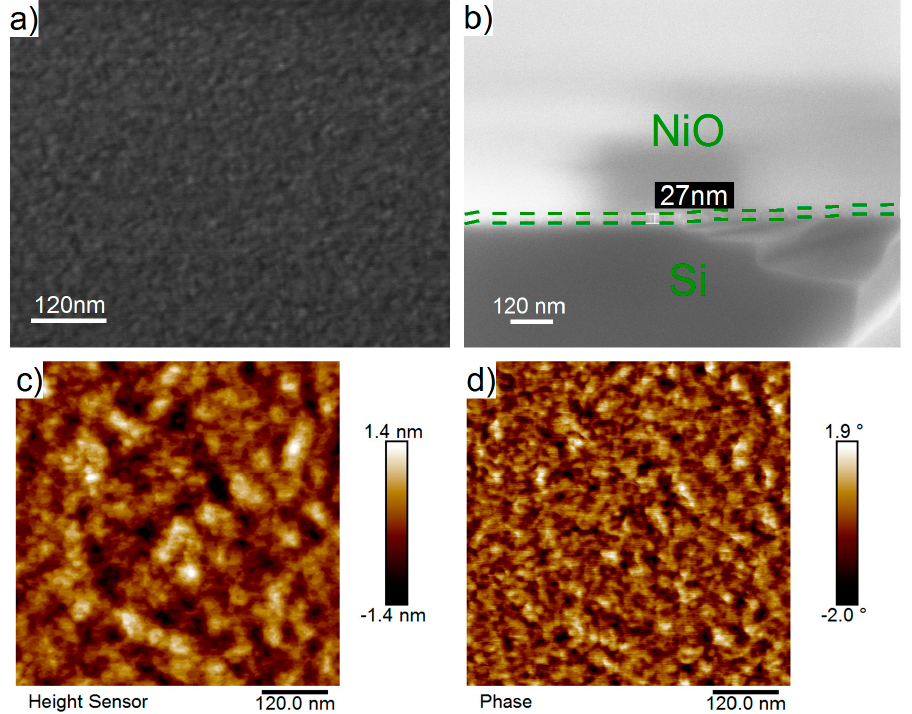
Figure 5. Plan-view and cross-sectional SEM images ( a , b ), AFM topography and phase contrast images ( c , d ) of NiO nanofilms deposited by ALD on silicon substrates using NiCp 2 and O 2 plasma at 300 °C during 2300 ALD cycles.